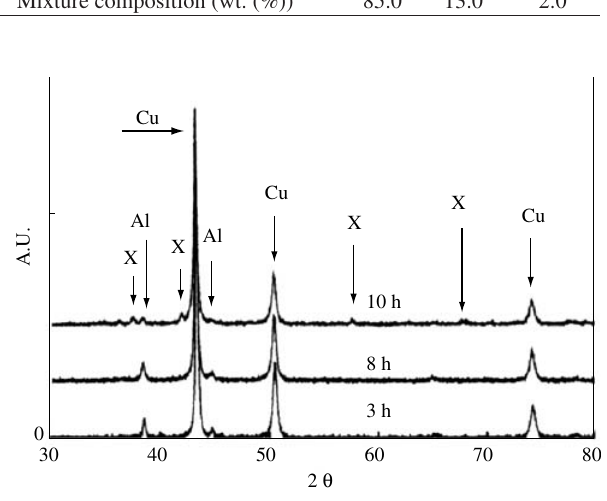
Figure 2. X-ray diffractograms of Cu-13Al-2Nb alloy with 1% zinc stearate milled at 150 rpm for different times.